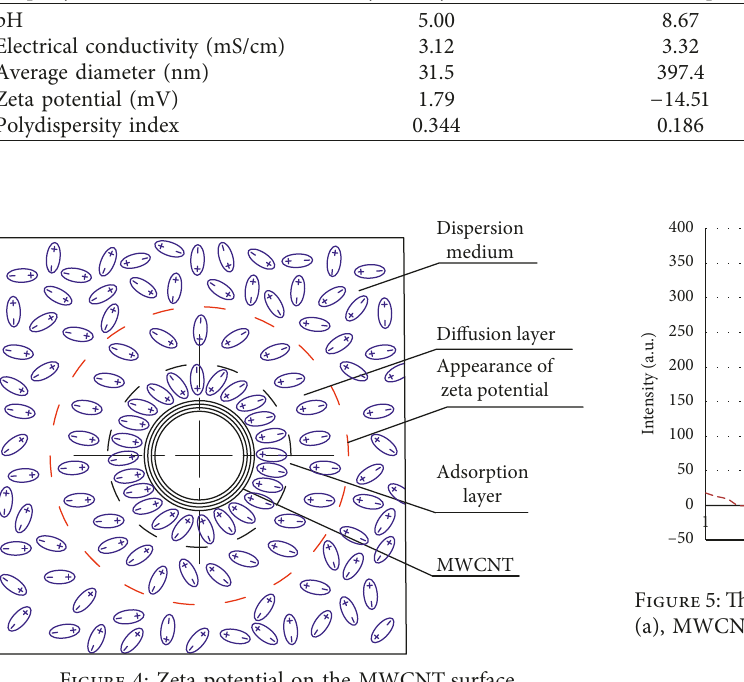
Figure 4: Zeta potential on the MWCNT surface.